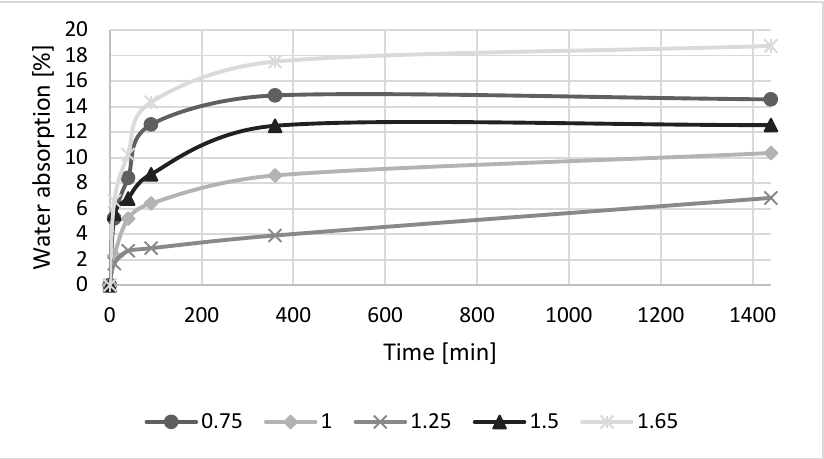
Figure 6. Water absorption results with different SiO 2 /Na 2 O molar ratio.